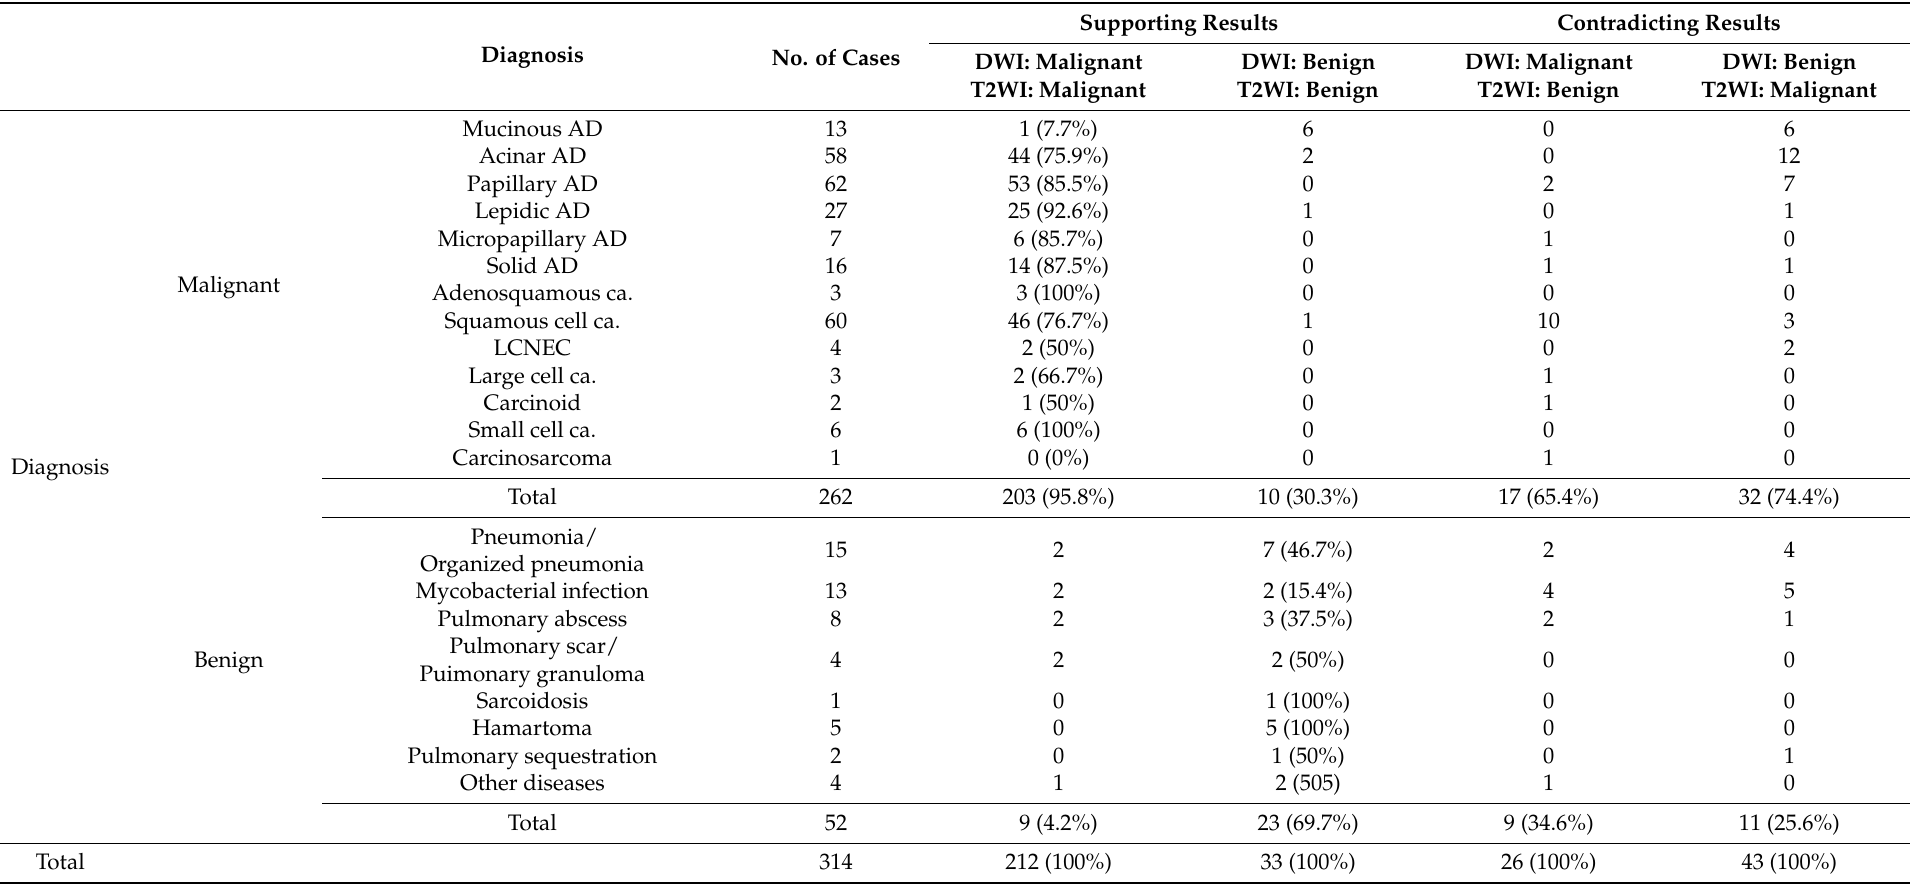
Table 2. Diagnostic efficacy by DWI and